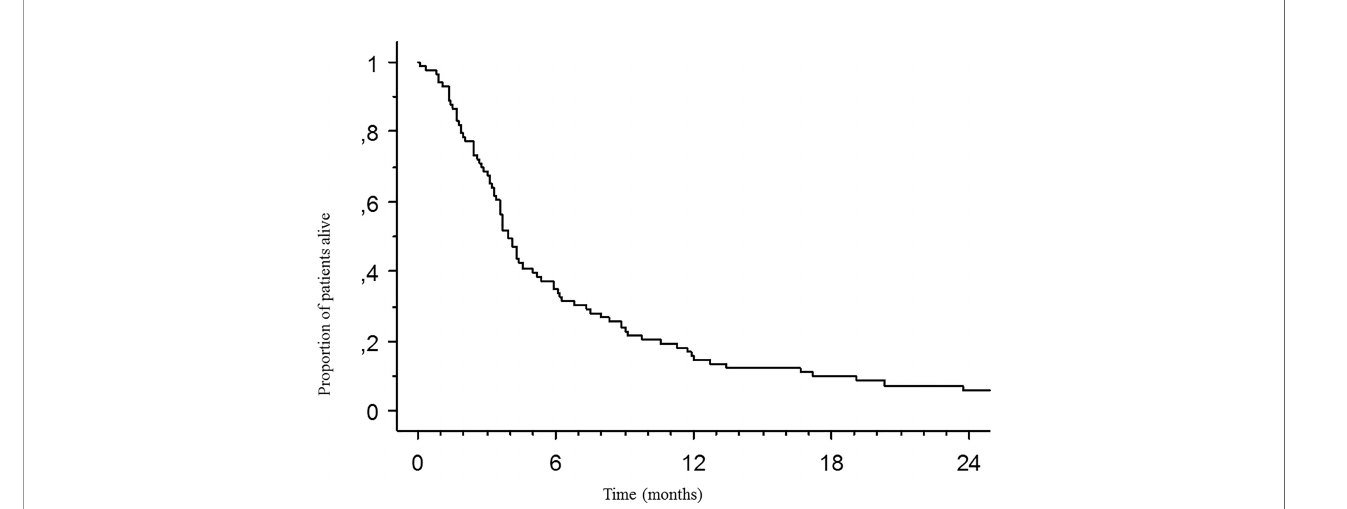
FIGURE 3 | Median overall survival (OS) after brain metastasis diagnosis. Kaplan Meier method was used to determine